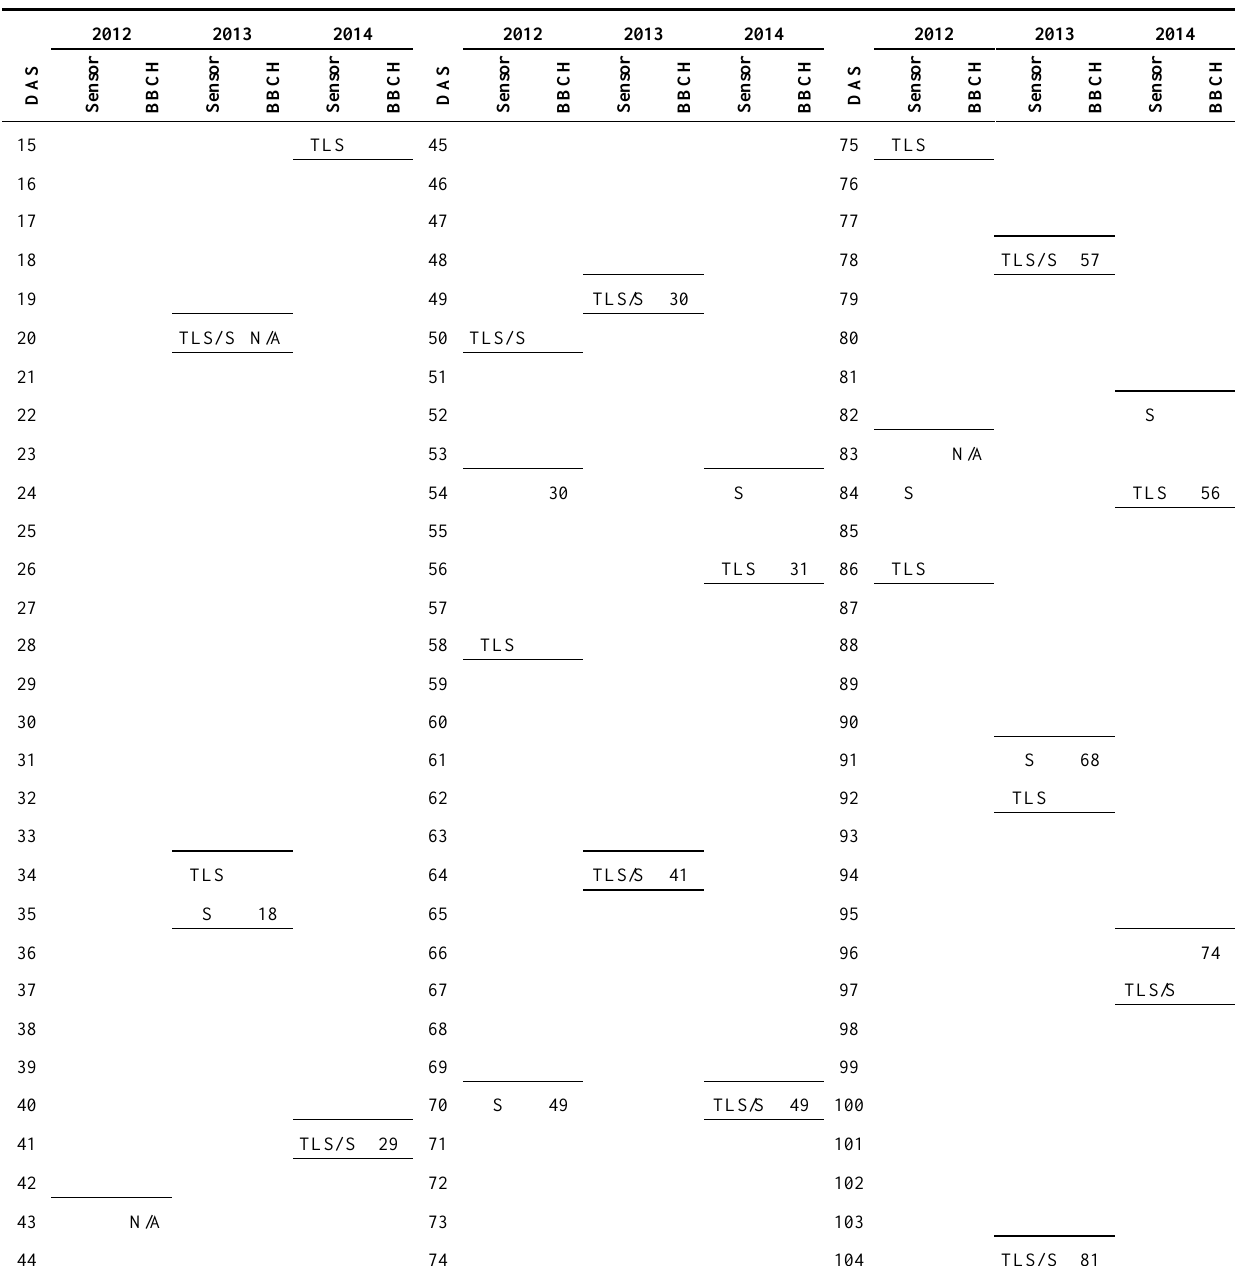
Table 1. Dates of the terrestrial laser scanning (TLS) and spectrometer (S) campaigns listed as day after seeding (DAS). Averaged codes for the developmental steps are given for the dates of manual plant parameter measurements (BBCH). For some dates BBCH codes were not determined